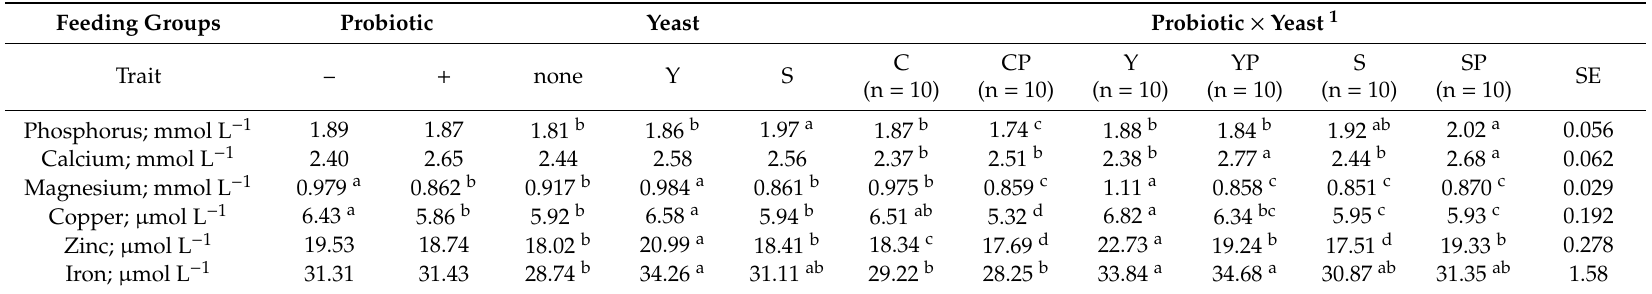
Table 4. Results of statistical analysis of mineral elements blood plasma in turkey